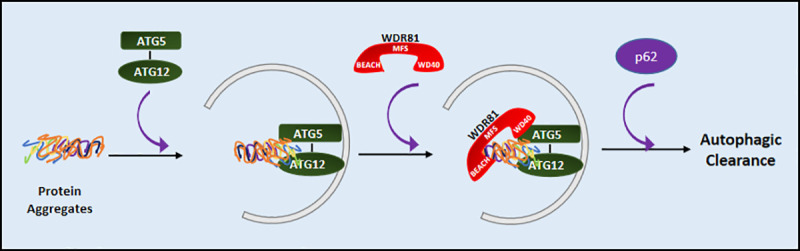
Model of WDR81-mediated autophagic clearance of protein aggregates.